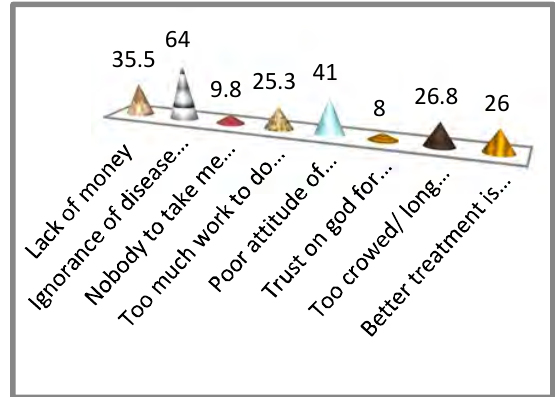
Fig. 1: Percentage distribution of factors